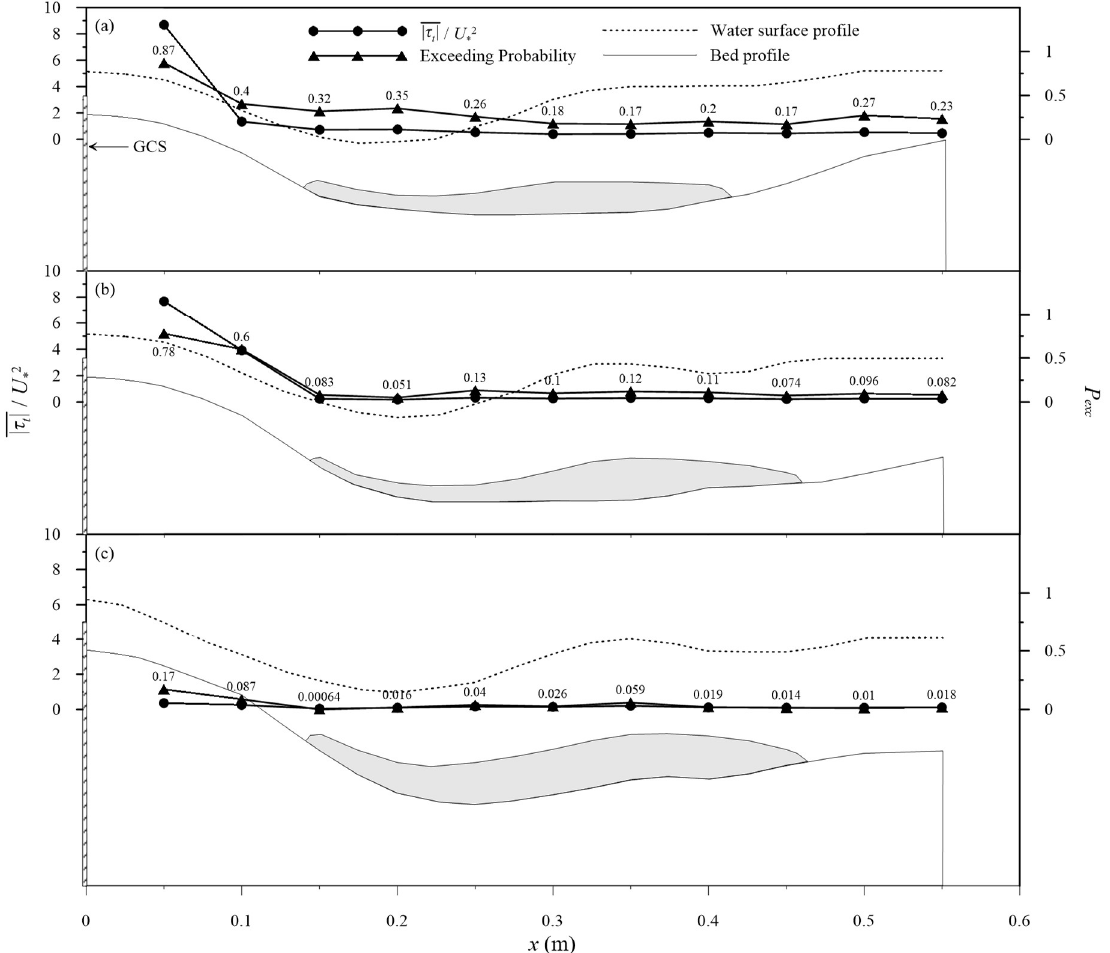
τ U 2 ) and the exceeding t *